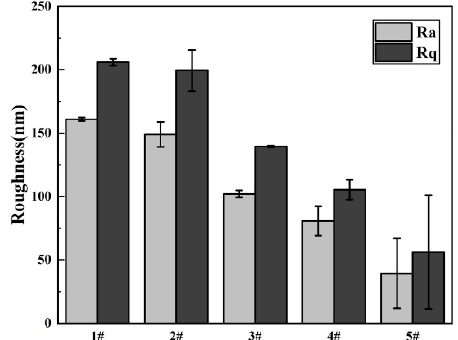
Figure 7. Surface roughness of MAO-WE43 and GelMA/MAO-WE43 samples. 1#: MAO-WE43; 2#: 1GelMA/MAO-WE43; 3#: 5GelMA/MAO-WE43; 4#: 10GelMA/MAO-WE43; 5#: 15GelMA/MAO- WE4.